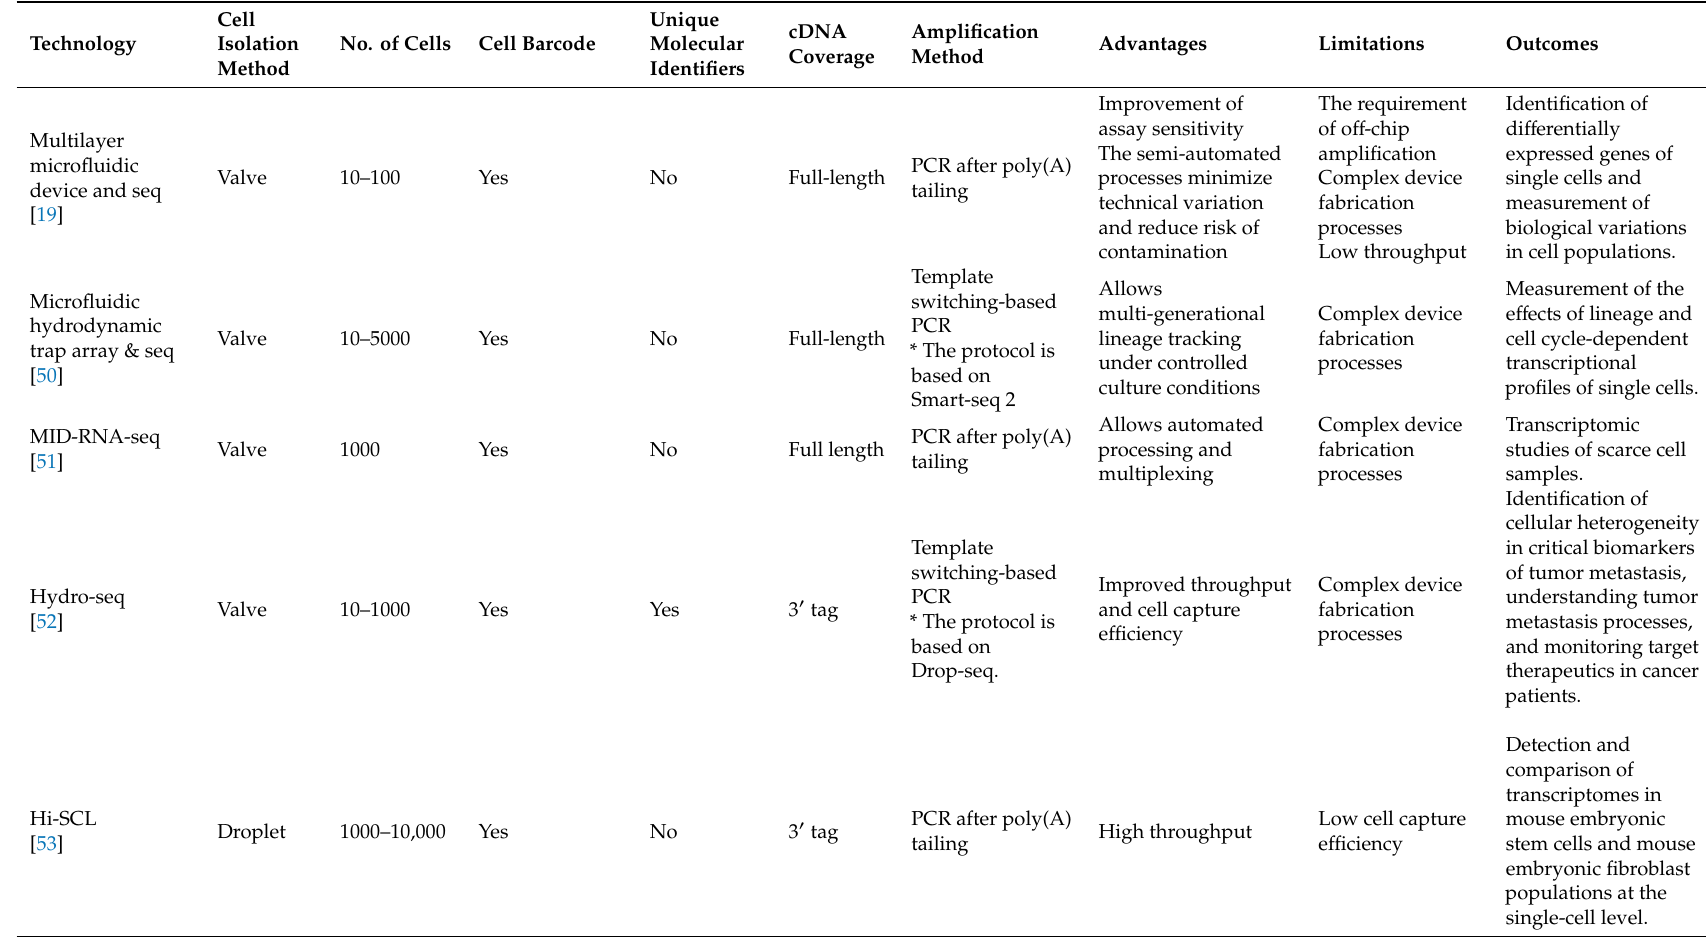
Table 2. Summary of microfluidic-based scRNA-seq